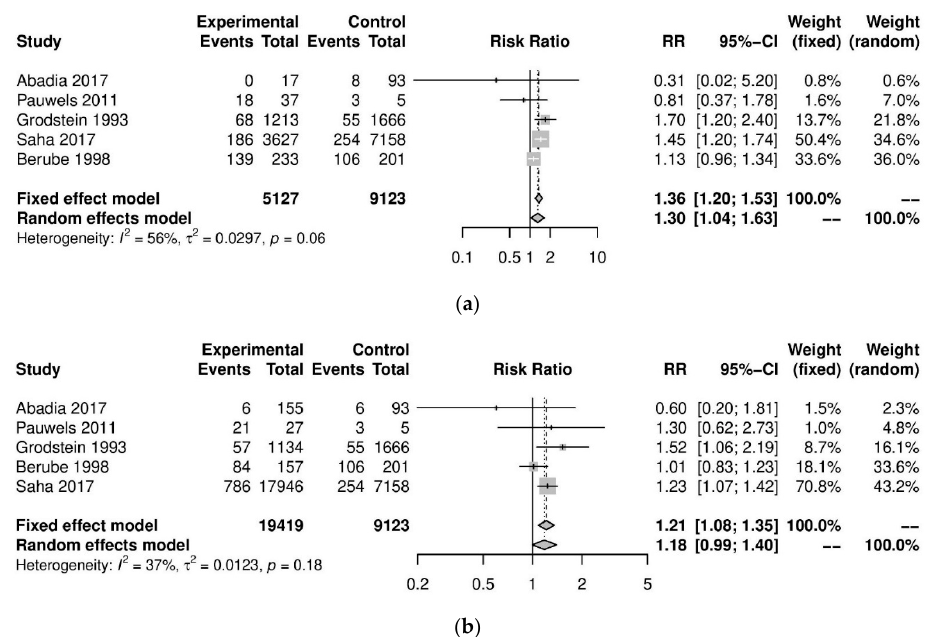
Figure 3. Analysis of ( a ) high caffeine intake (>300 mg/day) versus little or no caffeine (<100 mg/day) and ( b ) moderate caffeine intake (200–300 mg/day) versus little or no caffeine (<100 mg/day).